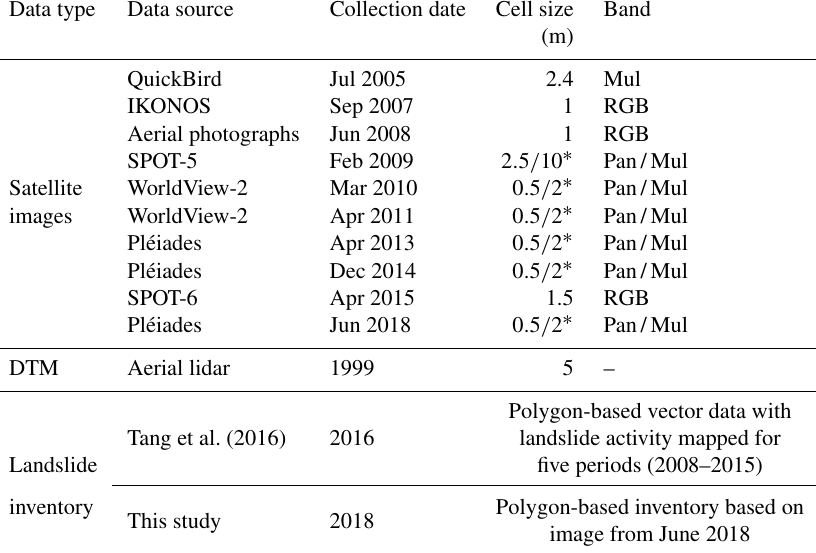
Table 1. Data used for interpretation (Pan is panchromatic image; Mul is multispectral image; RGB is red–green–blue color composite). ∗ Cell size corresponds to